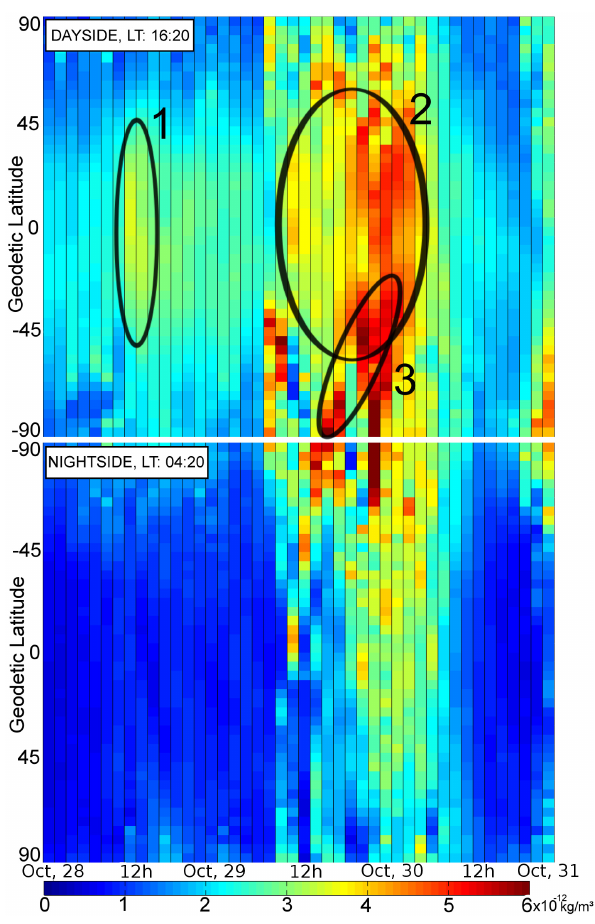
Fig. 5. Impact of the geomagnetic storm on the upper Earth atmo- sphere, in terms of normalized neutral densities ρ 490 determined from GRACE satellite accelerations during 28–30 October 2003 at the dayside (LT: ∼ 16:20) and at the nightside (LT: ∼ 04:20). The time interval between two adjacent vertical grid lines covers a sin- gle satellite revolution (94min) and defines the time resolution of the plot. (1) corresponds to the measured density enhancement at the satellite orbit location caused by the X17.2 flare. (2) and (3) are density enhancements which originated a day after the flare expo- sure due to the accompanied CME and related high energy particle